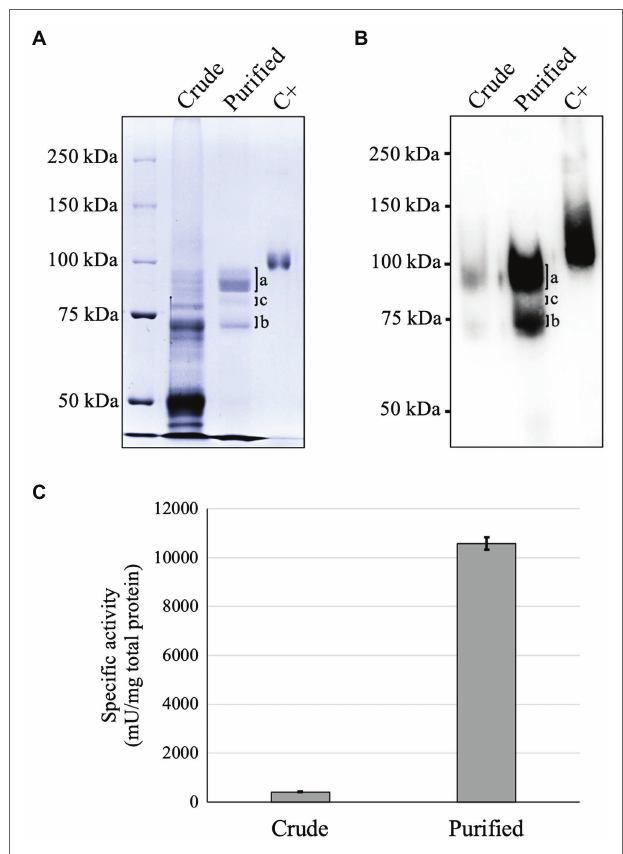
FIGURE 2 | Analysis of GAA purified from GAA-producing Arabidopsis alg3 cell culture by Coomassie Brilliant Blue (CBB) staining (A) , Western blot (B) , and GAA activity assay (C) . Marks a and b indicate the 95 and 76 kDa GAAs, respectively, whereas mark c indicates a degraded GAA ( Supplementary Figure 1 and Supplementary Table 1 ). C+ is human embryonic kidney/ HEK293-derived recombinant human GAA used as a positive